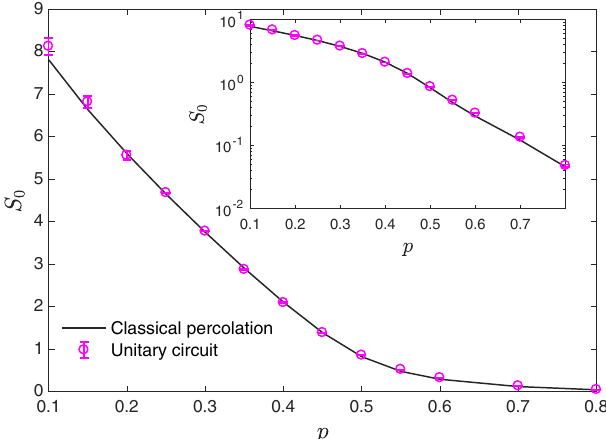
FIG. 5. Example comparison between the unitary circuit and classical percolation results for the zeroth R´enyi entropy, S 0 , between two halves of a spin chain that has undergone unitary evolution. In this example, the circuit contains L ¼ 24 spins, and the evolution time is t ¼ 48 . The value of p on the horizontal axis represents the probability of measurement for each spin after each time step. The magenta circles with error bars show the result of the full simulation of the unitary circuit, while the black line shows the result of the classical percolation simulation. The inset shows the same data on a logarithmic